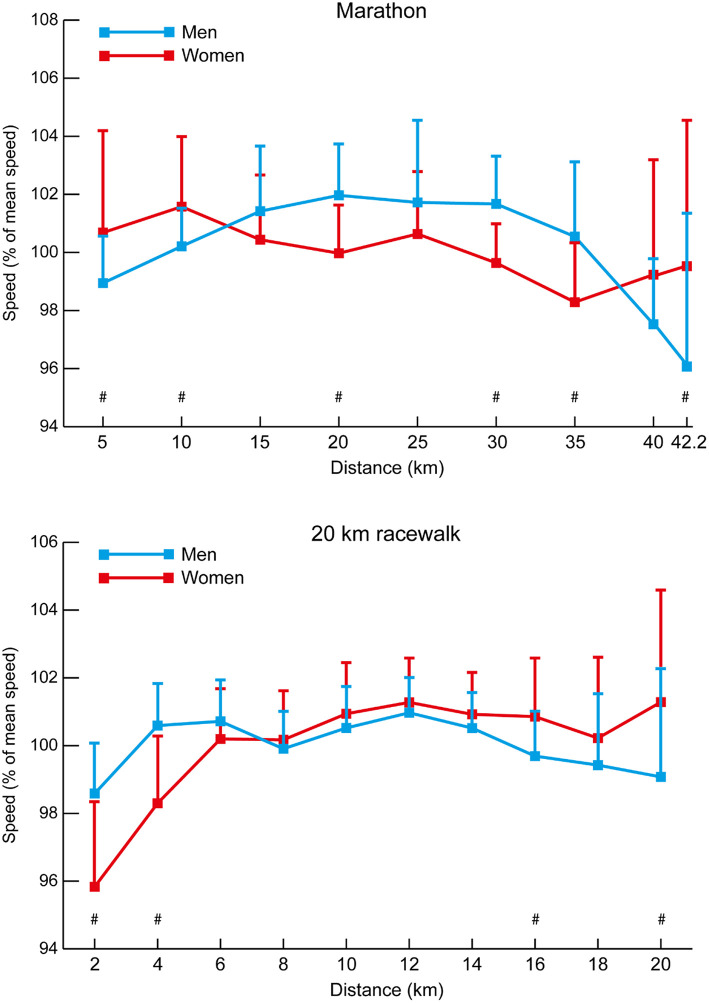
The mean (+ SD) section speed expressed as a percentage of mean speed for all men and women in the marathon and 20 km racewalk events. Differences in segment speed percentage between men and women (p < 0.05, d ≥ 0.61) have been annotated (#).